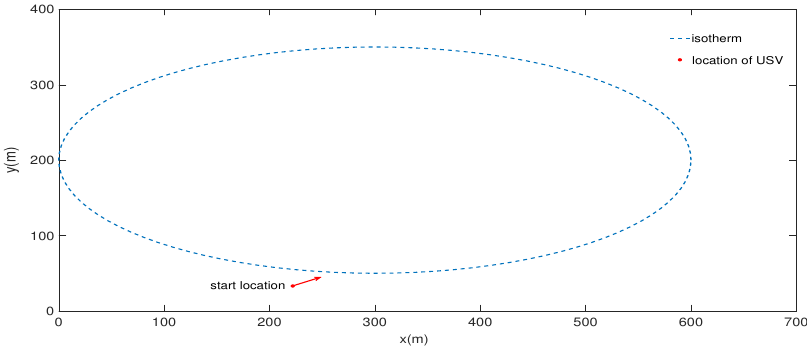
Figure 11. Fitting the isotherm of an